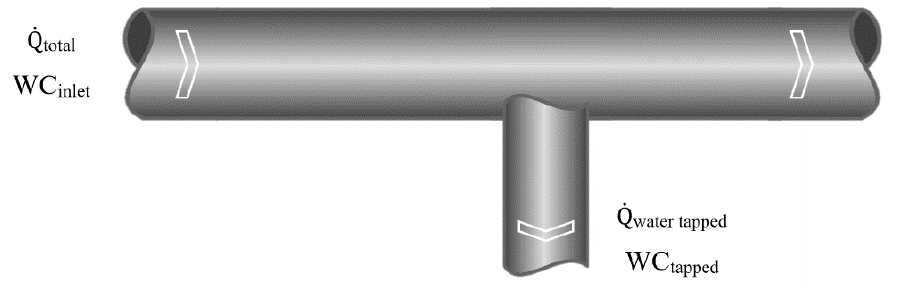
Figure 1. Tapping of stream.